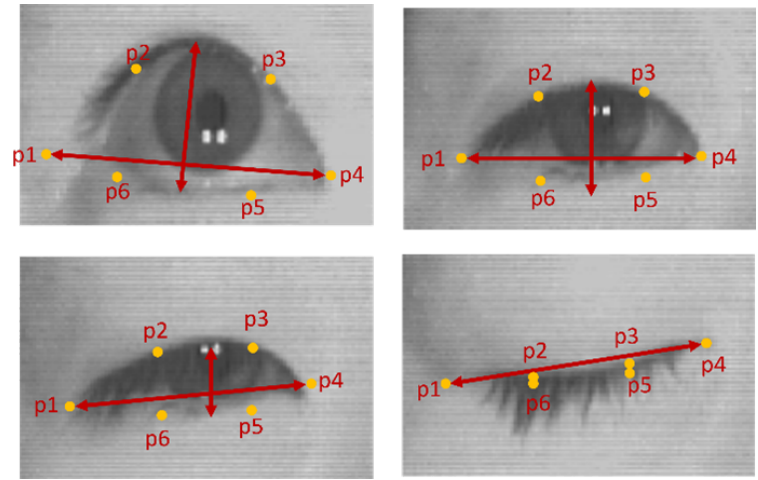
Figure 4. Eye opening and closing state